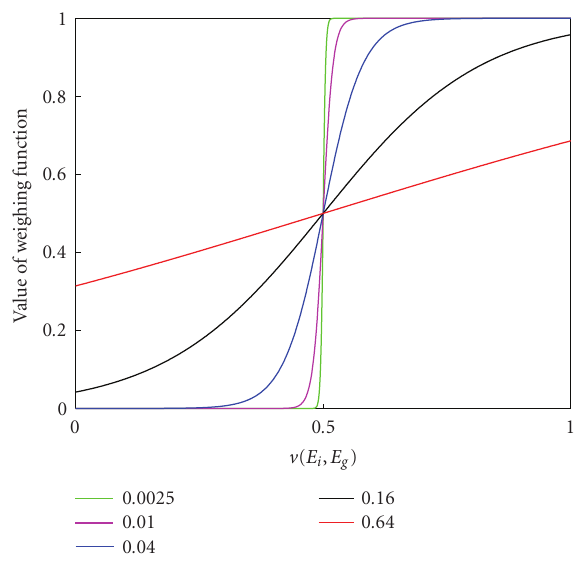
Figure 3: A slice of 3D GCM of PET. (a) Original image, (b) gradi- ent magnitude map, (c) gradient phase map, (d) GCM ( Δ ρ = 1 / 16, Δ = π/ 8, Δ = π/ 8, and Th = 0 . 16). φ θ